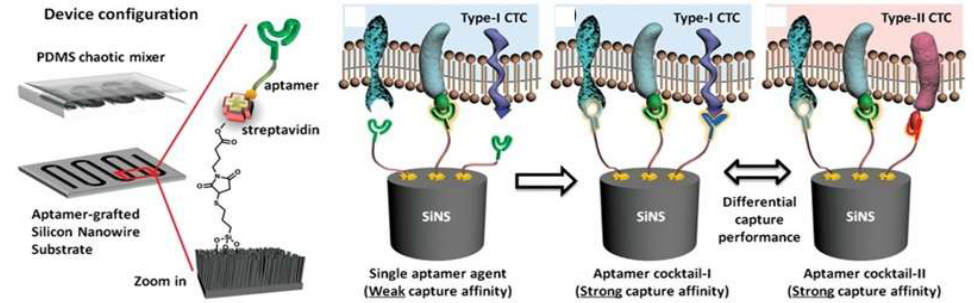
Figure 4. A representative chaotic mixer microfluidic device combined with an aptamer cocktail-grafted silicon nanowire substrate (SiNS). The different aptamers work synergistically to enhance capture affinity in a low-concentration target. Reproduced with permission from reference [68]. Copyright 2016 John Wiley and